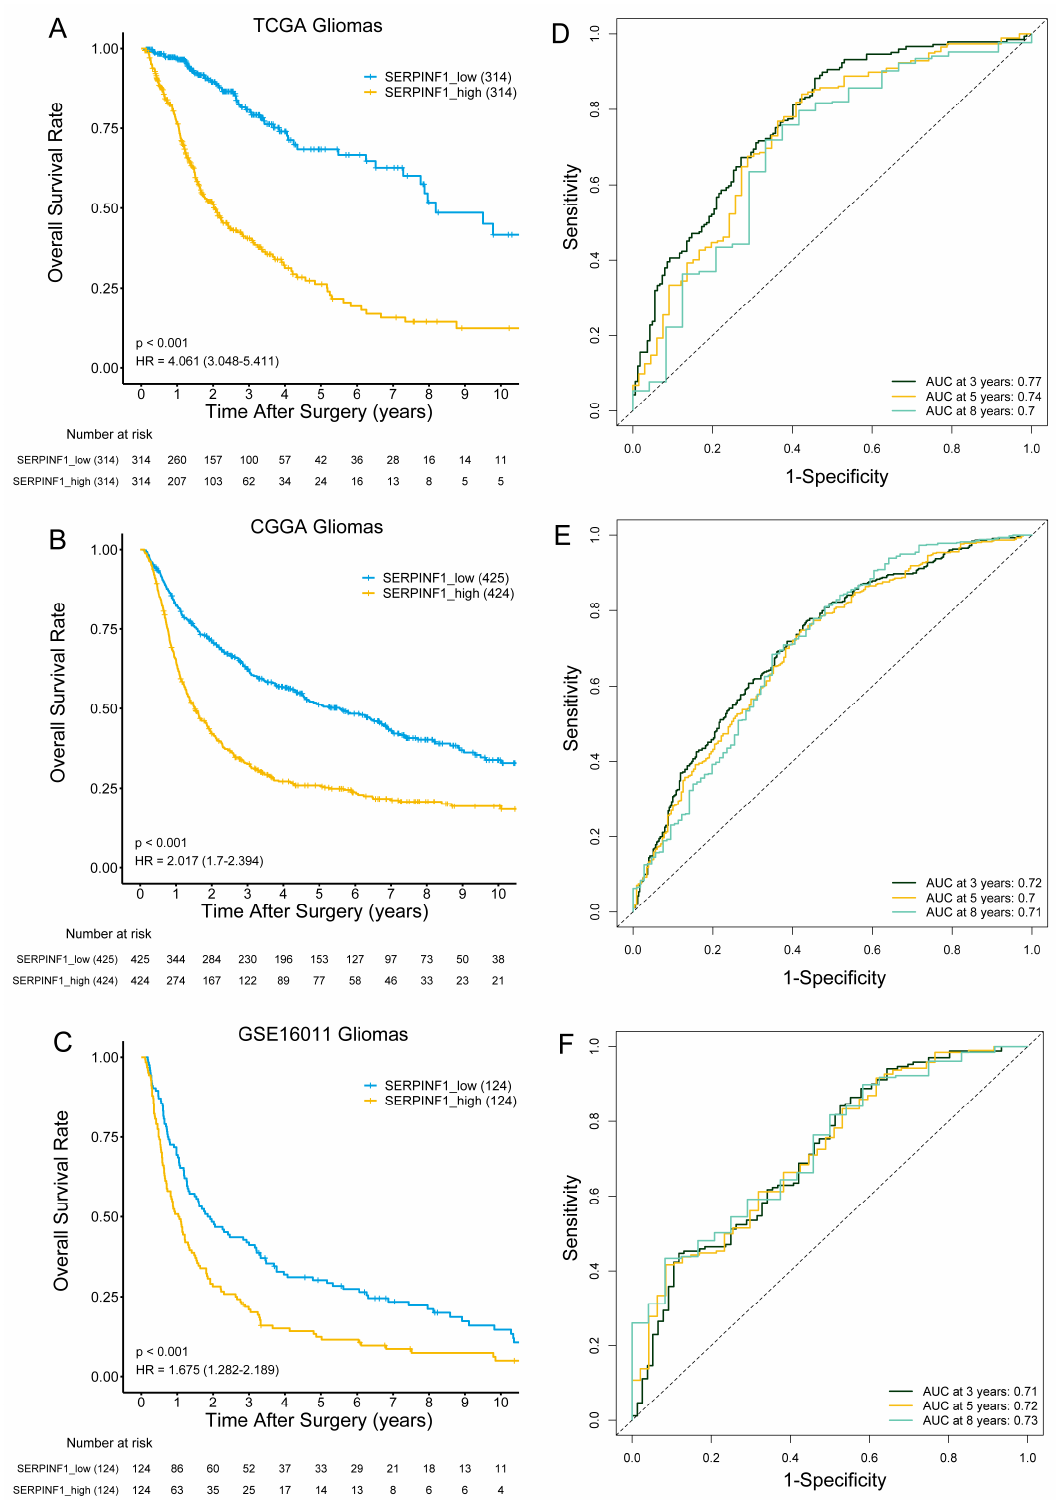
Figure 2. The prognostic value of SERPINF1 expression in glioma. Kaplan–Meier survival curves of the high- and low-SERPINF1 groups in TCGA ( A ), CGGA ( B ), and GSE16011 ( C ). Time-dependent ROC curves for predicting 3-, 5-, and 8-year survival based on SERPINF1 expression in TCGA ( D ), CGGA ( E ), and GSE16011 ( F ).